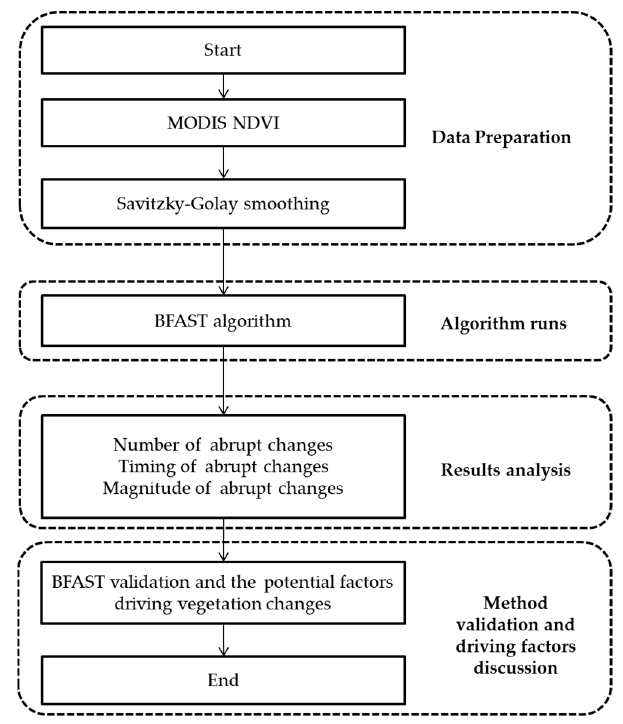
Figure 2. Schematic diagram representing the processing steps undertaken in this